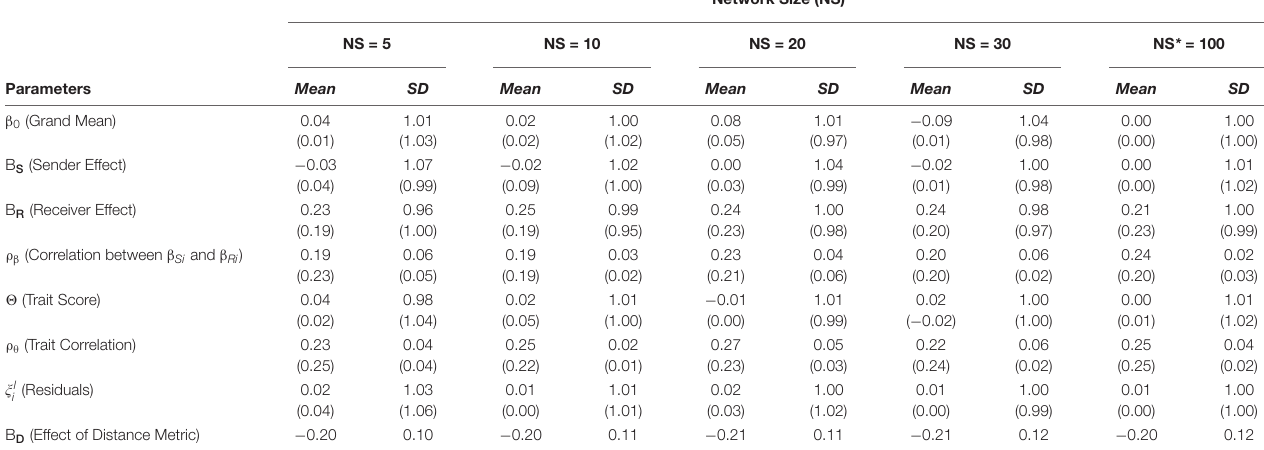
TABLE 3 | Means and standard deviations of simulated values for model